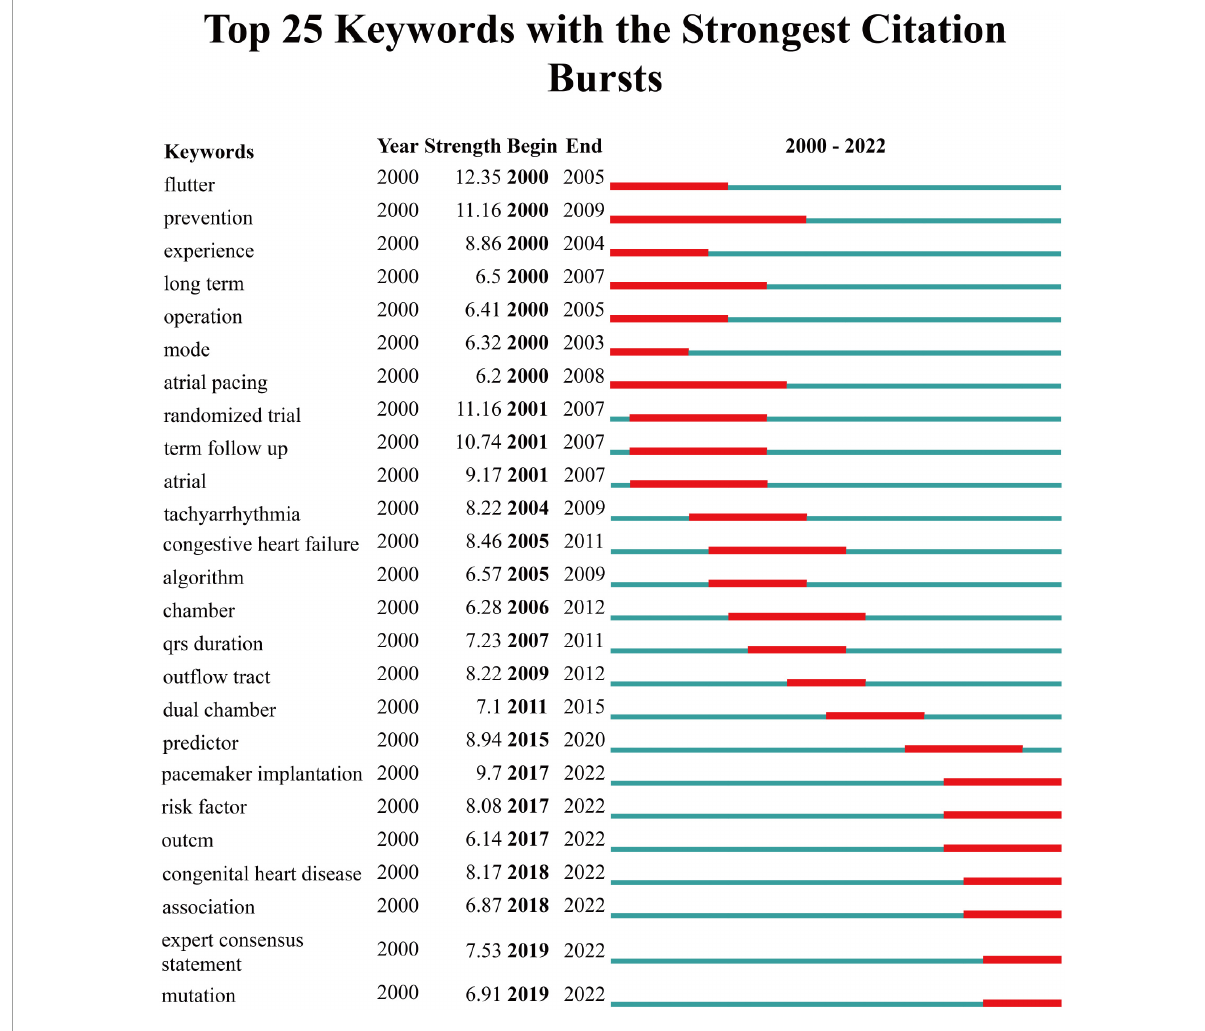
FIGURE6 Top 25 Keywords of SSS with the strongest citation bursts based on